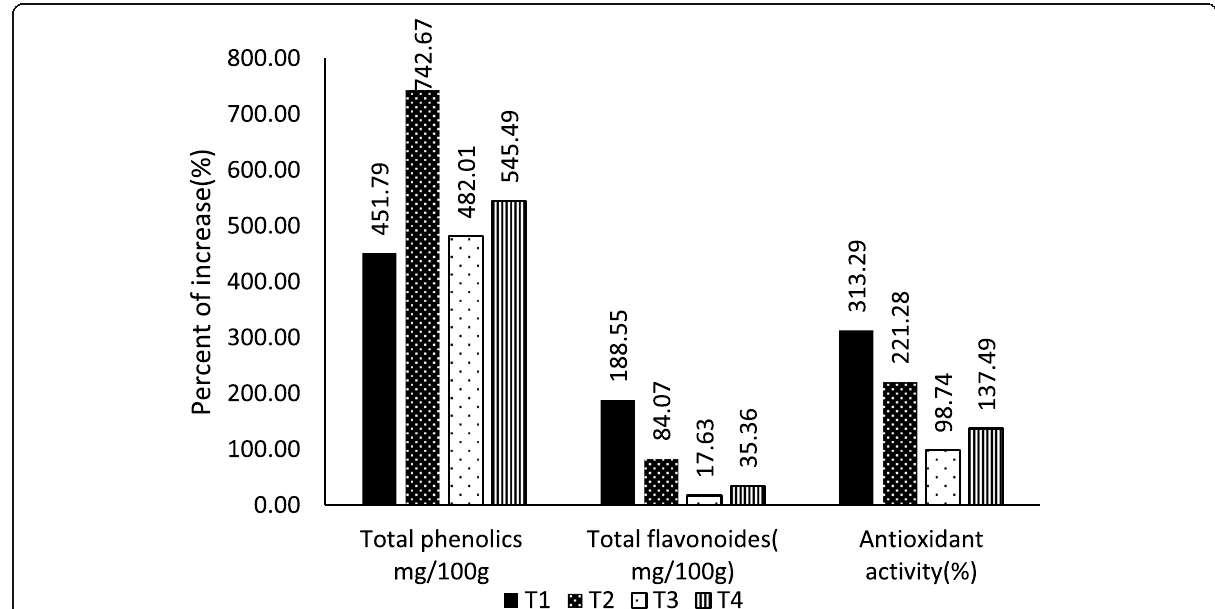
Fig. 4 The increasing percent of functional properties in treatments as compared to control. Control: plain extruded product. T1, T2, T3 and T4: extruded corn products fortified with 3% (w/w) of Laurel, turmeric, ginger and mixture formula contains 3% of mix of the three herbs used (1:1:1),